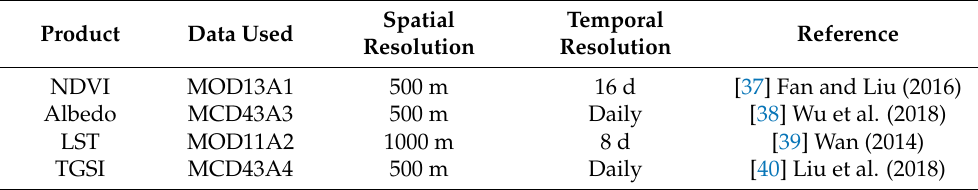
Table 1. Summary of the four typical surface parameters.